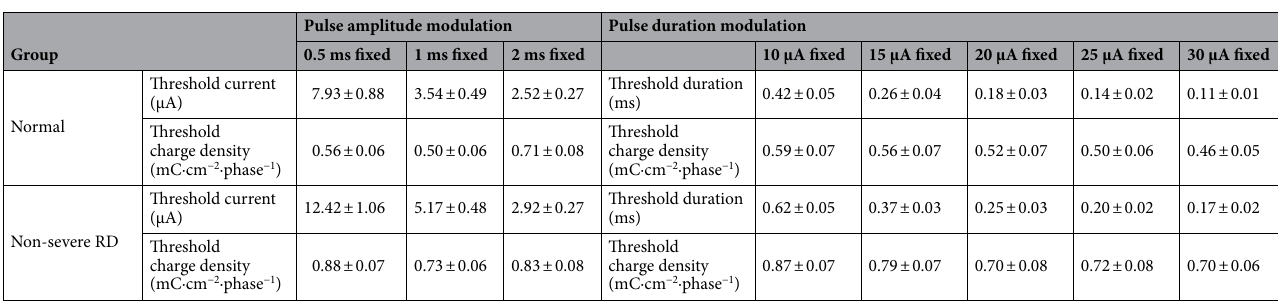
Table 1. Threshold values (mean ±